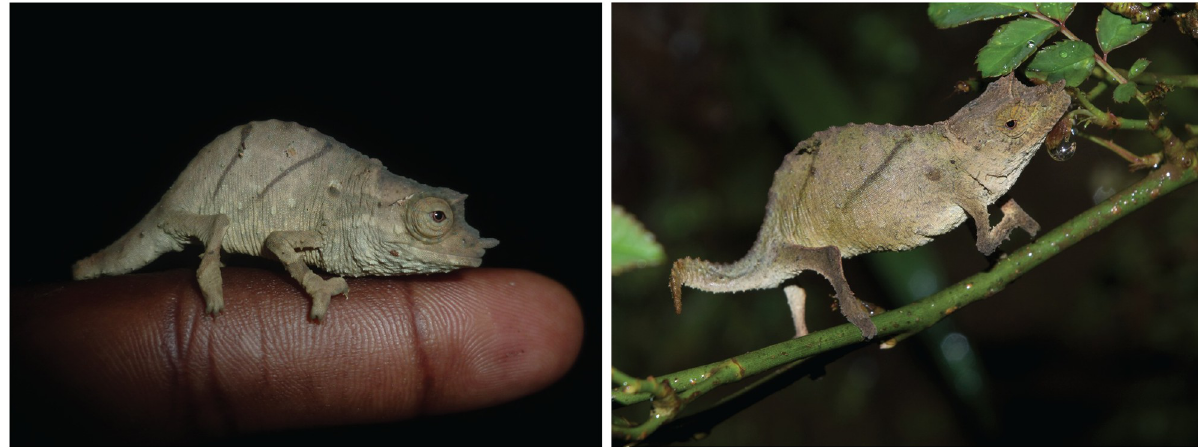
Fig 1. Rhampholeon spectrum . (Left) Male from Ekona Lelu, Mt. Cameroon. (Right) Female from Mt. Kupe. Photograph credit Luke Welton (right